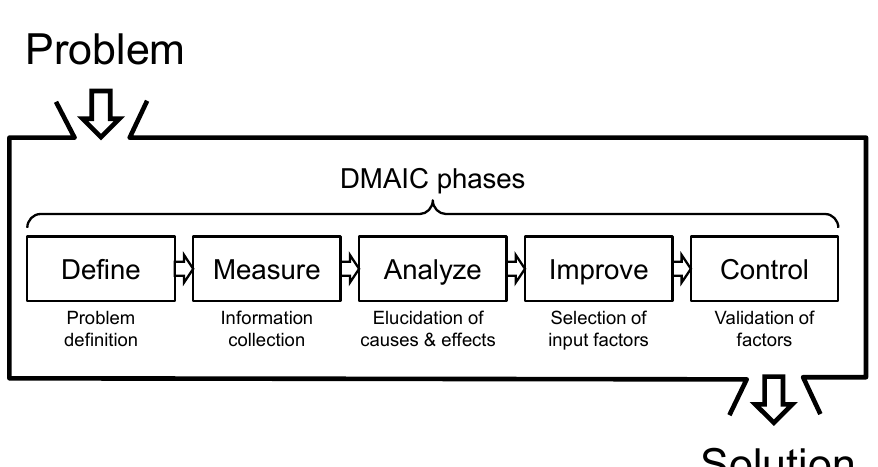
Figure 3. DMAIC phases of the Six Sigma approach; DMAIC represents Define, Measure, Analyze, Improve, and Control. This approach is adapted to improve the quality and the yield for nanotip fabrication process.